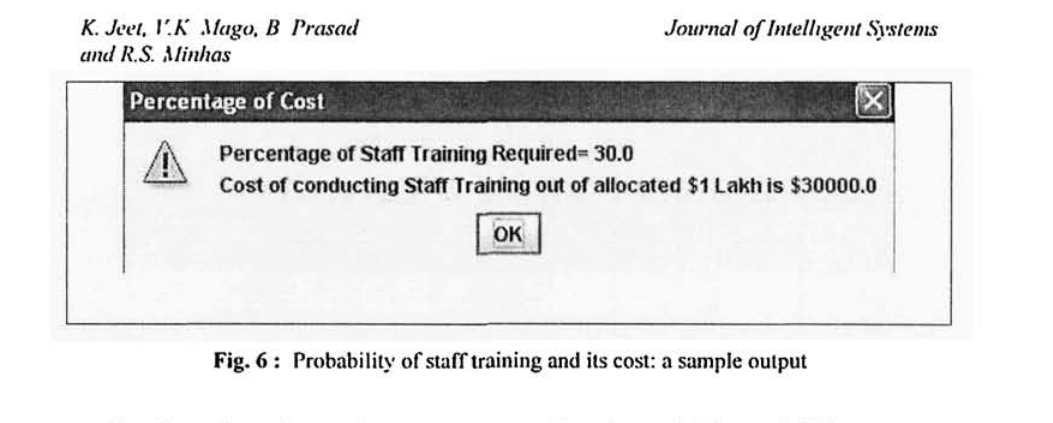
Fig. 6 : Probability of staff training and its cost: a sample